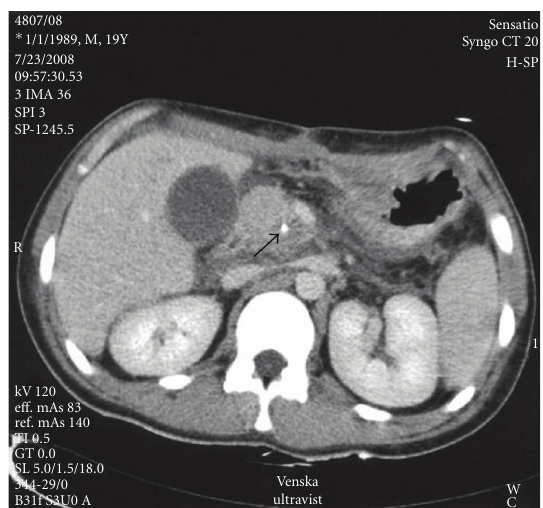
Figure 7: CT scan 24 hours post embolisation in delayed venous phase (45sec), collimation 5mm showing complete thrombosis of pseudoaneurysm. Hyperdense small round object (arrow) consis- tent with